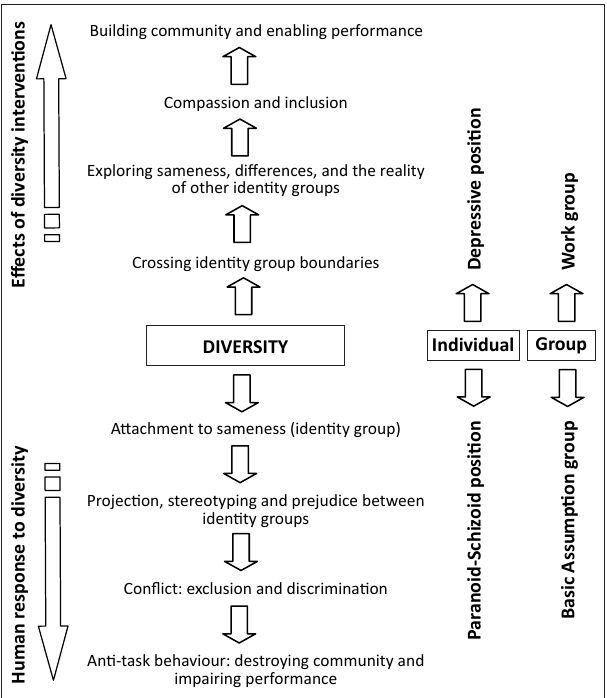
FIGURE 1 : The Community Building